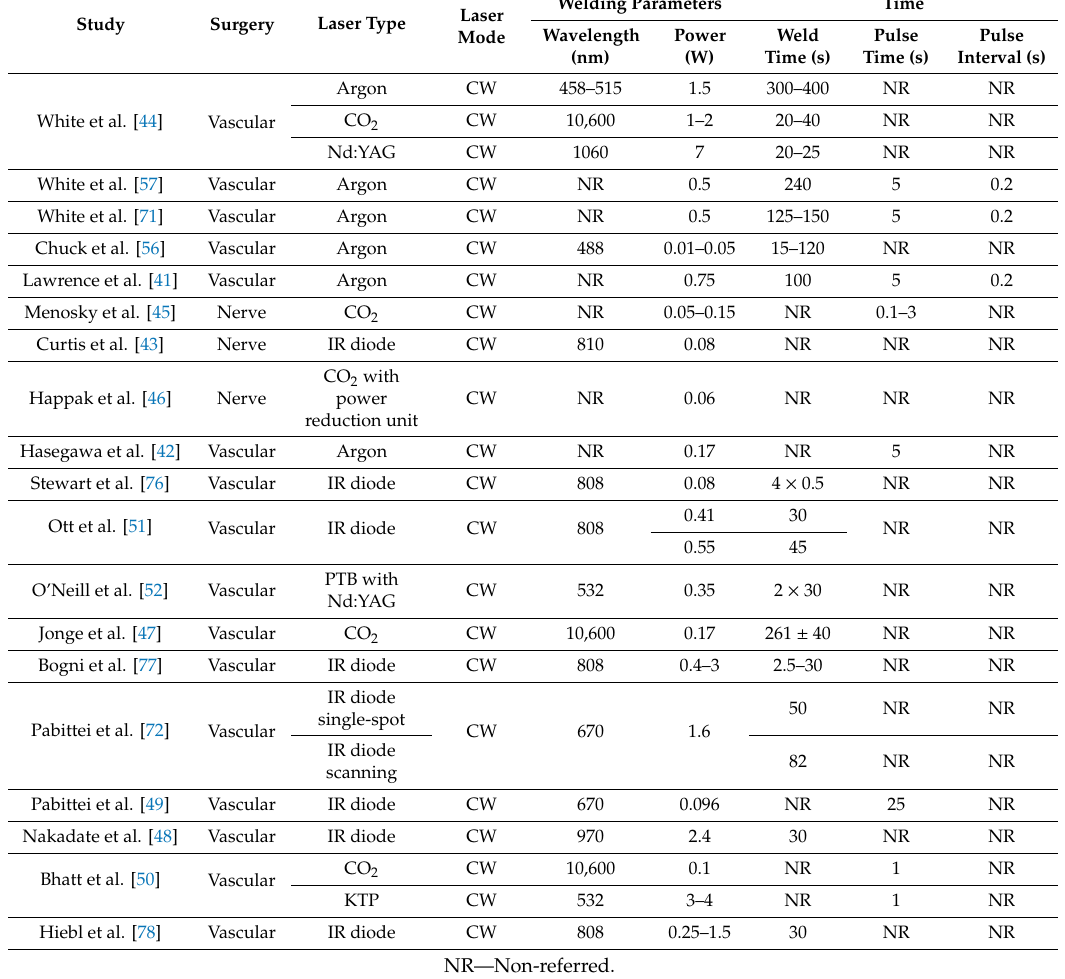
Table 5. Chronological overview of laser-welding results in vascular and nerve repair.